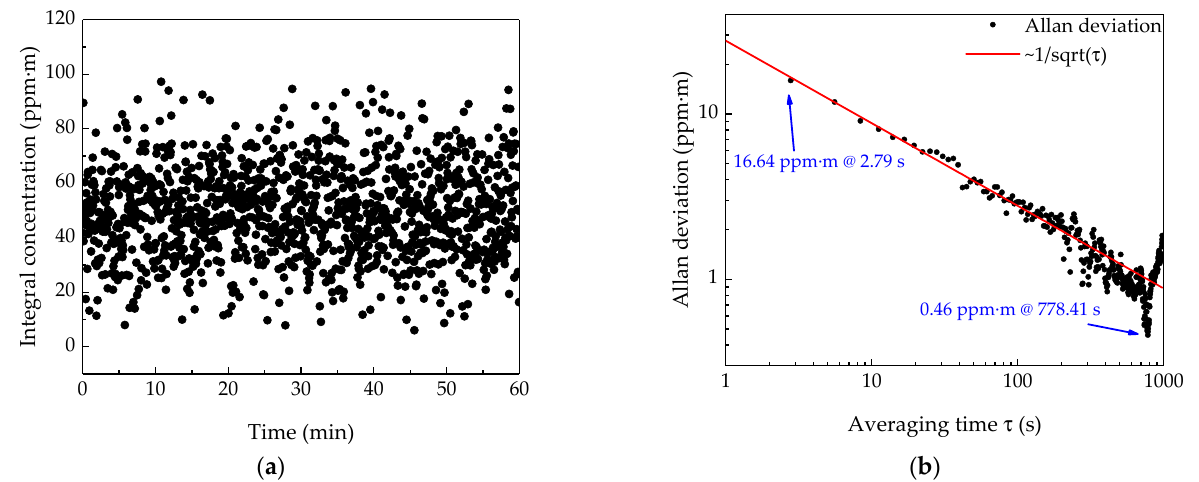
Figure 7. ( a ) The stability test of the remote sensor system for 1 h in the corridor of the building. ( b ) Allan deviation analysis of the sensor based on the stability test data shown in ( a ).